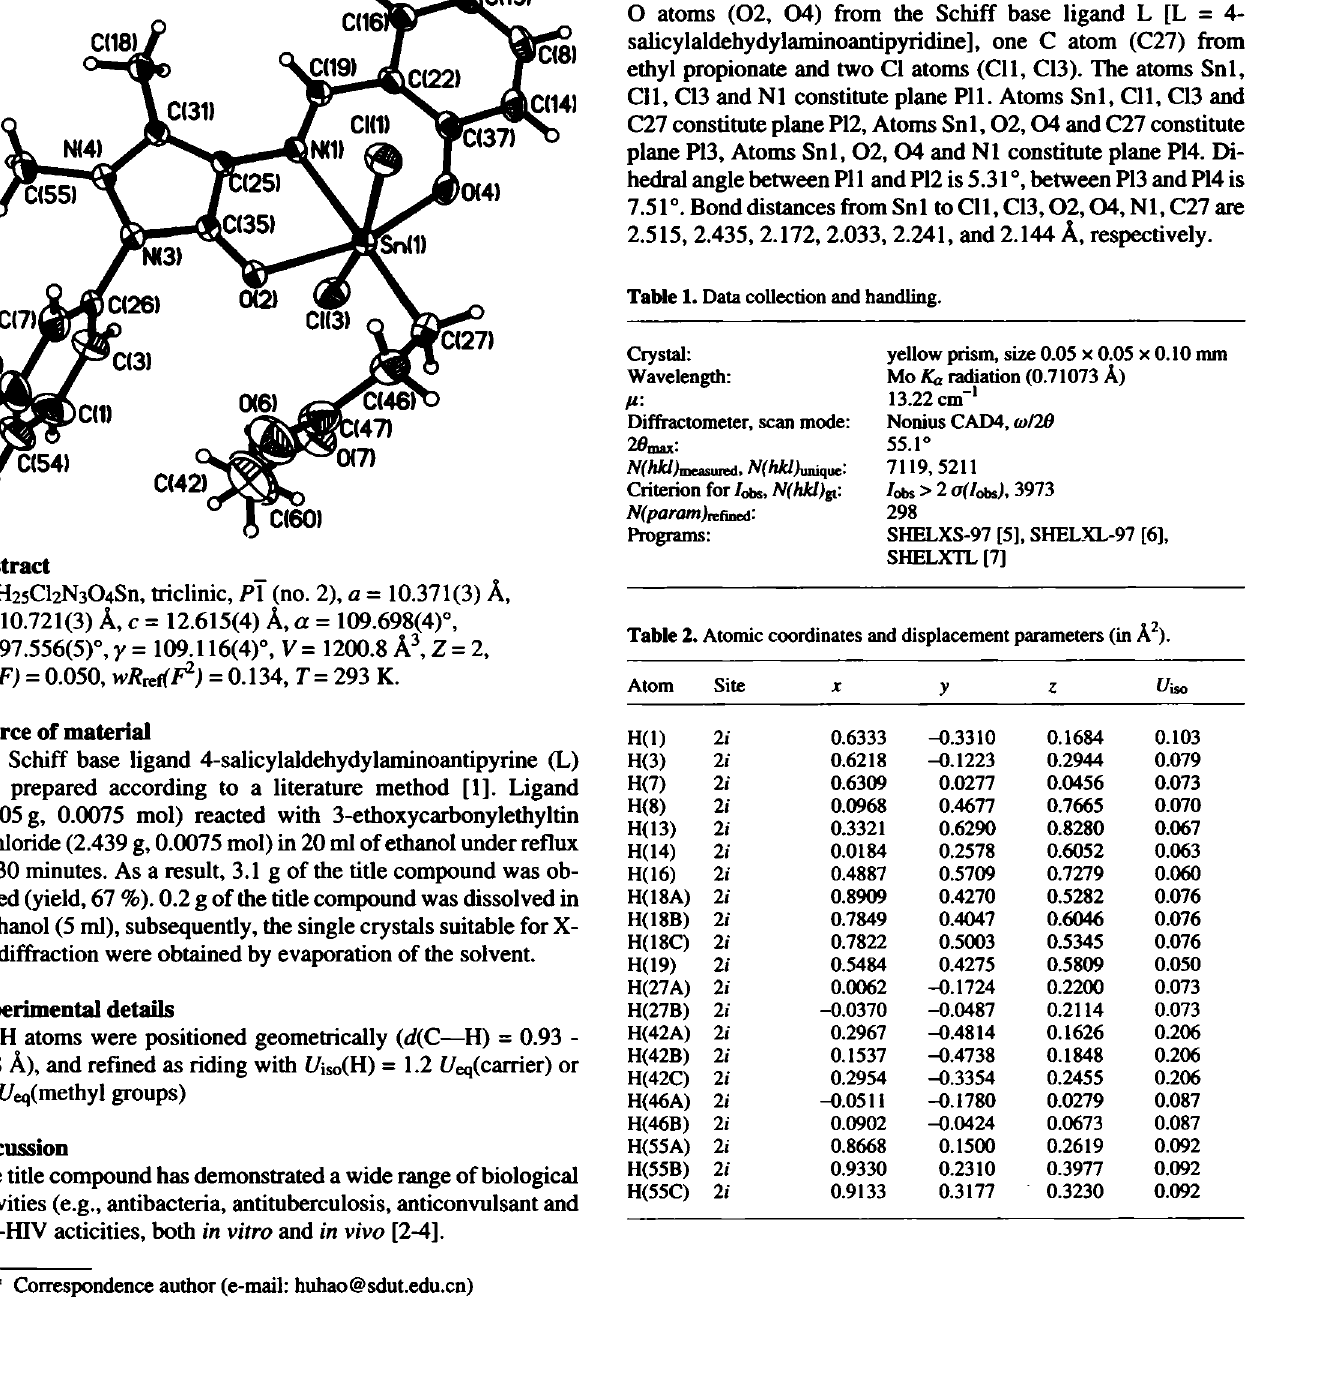
Table 2. Atomic coordinates and displacement parameters (in Â 2